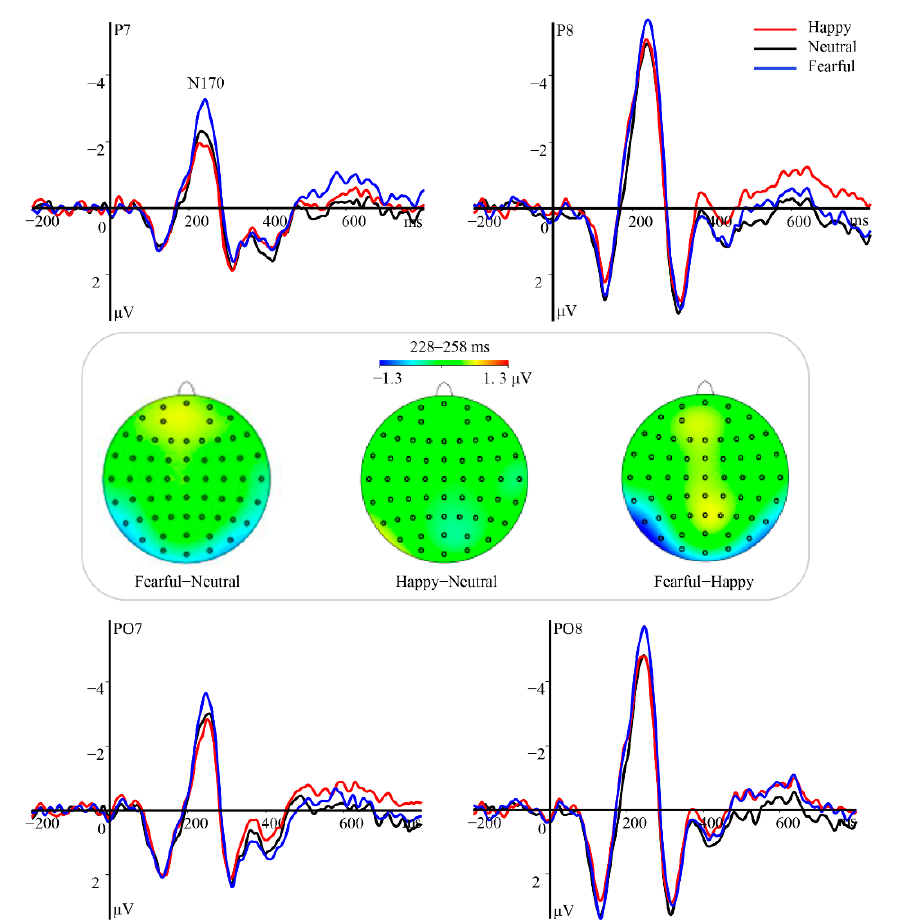
Figure 5. Main effect of emotional valence of eye regions on N170 amplitudes in Experiment 3. Top and bottom panels: Grand average ERP waveforms of N170 for happy (red line), neutral (black line), and fearful (blue line) eye regions at the indicated electrodes. Middle panel: Topographical difference maps depicting the effect of emotional valence in the eye region on the time window of N170.